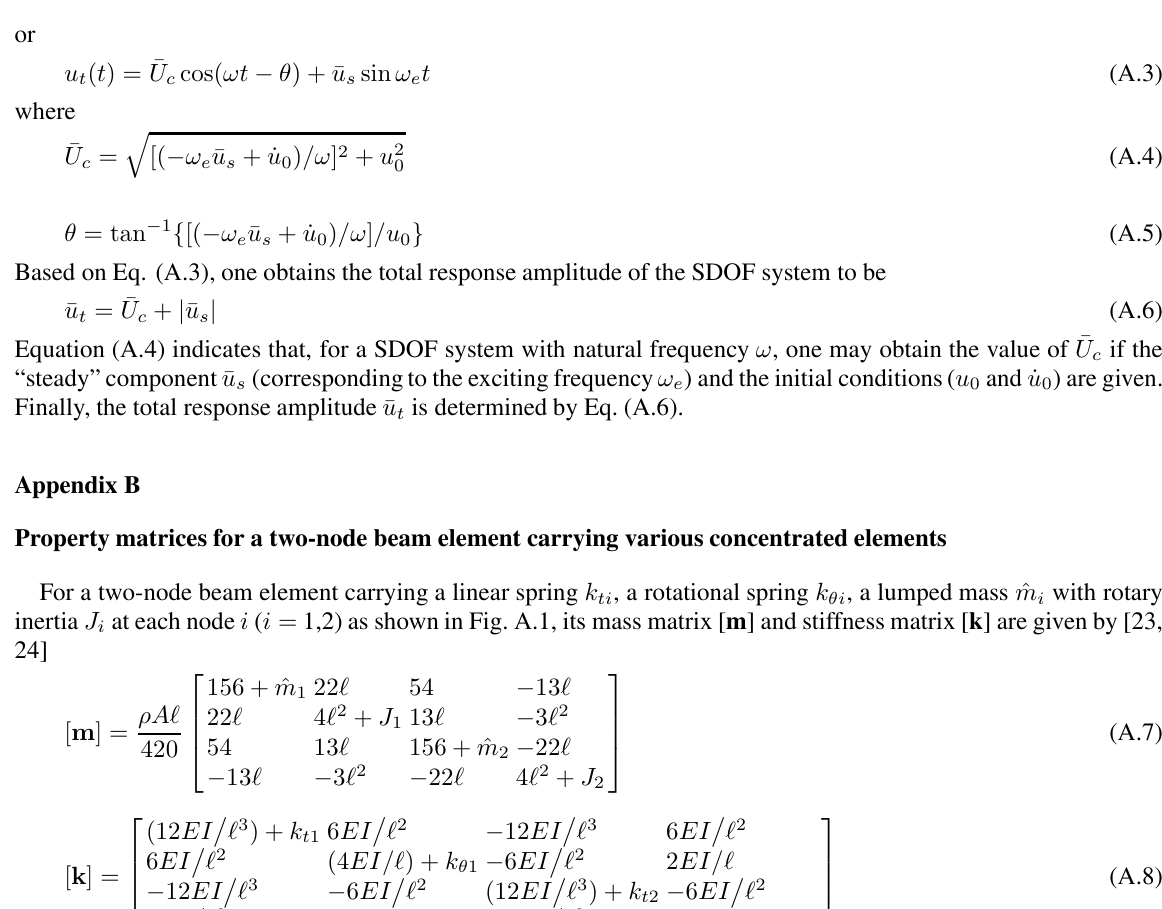
Fig. A.1. A two-node beam element carries a linear spring k ti , a rotational spring k θi , and a lumped mass ˆ m i with rotary inertia J i at each node i ( i = 1,2) and has four degrees of freedom (DOF’s), v 1 , v 2 , v 3 and v 4 , where v 1 and v 3 are the translational DOF’s and v 2 and v 4 are the rotational